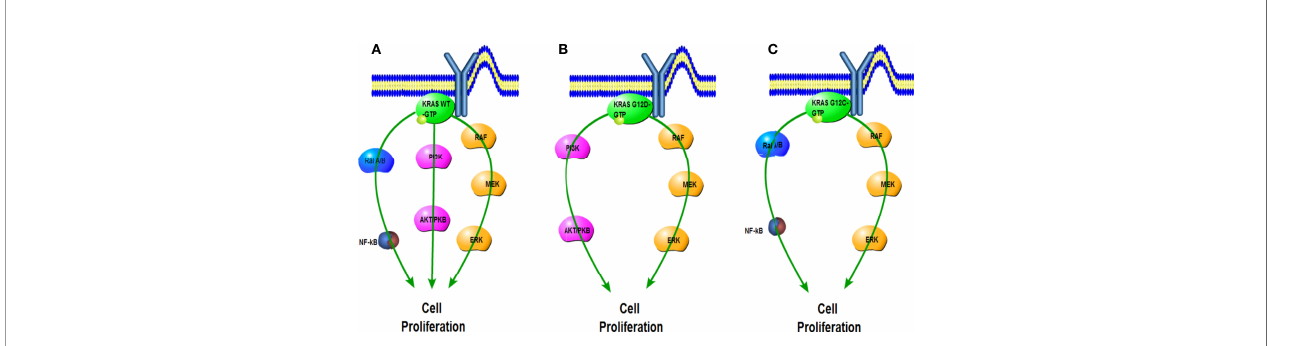
FIGURE 3 | Impact of G12C and G12D mutations on KRAS downstream pathways compared with wild type. (A) Activated KRAS wild-type signals the Ral A/B, PI3K, and RAF pathways. (B) KRAS G12D preferentially activates the PI3K and RAF pathways. (C) KRAS G12C preferentially activates the Ral A/B and RAF